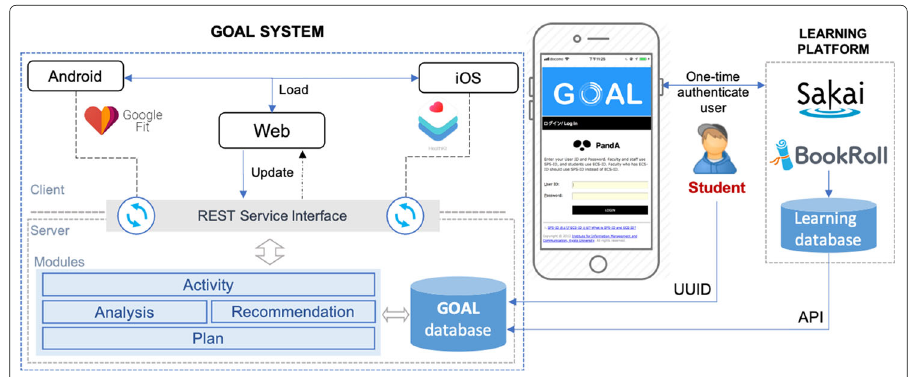
Fig. 1 Architecture of the GOAL system (Majumdar et al.